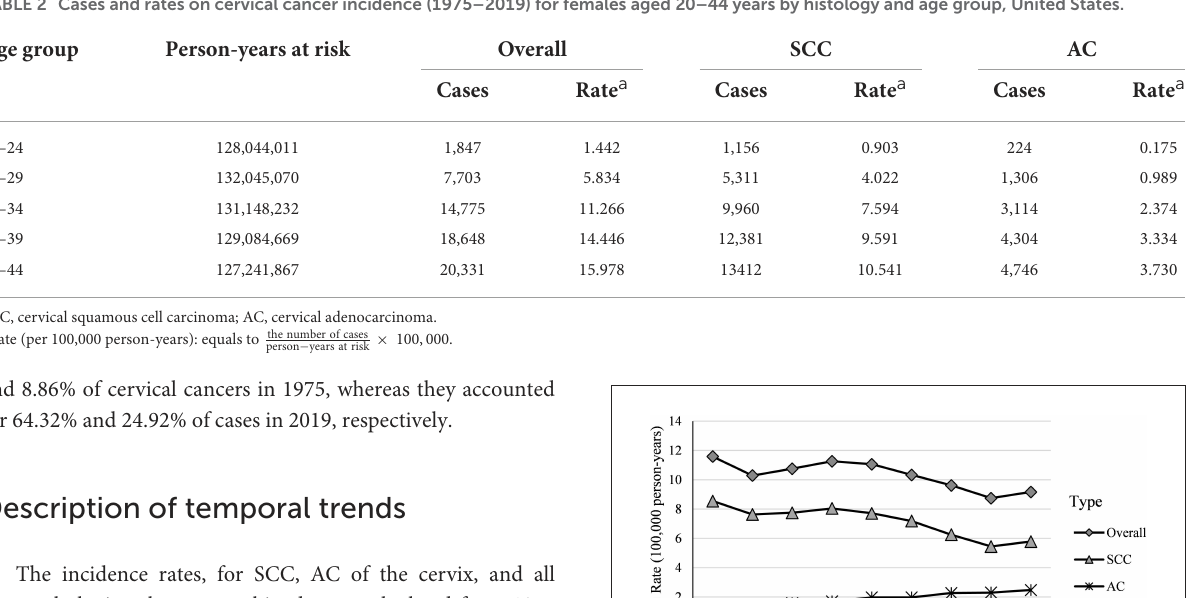
TABLE 2 Cases and rates on cervical cancer incidence (1975–2019) for females aged 20–44 years by histology and age group, United States.